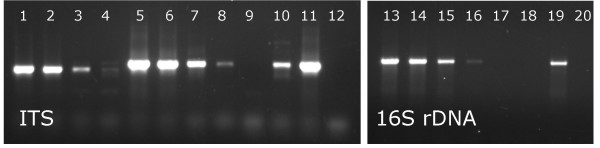
Contamination checking: PCR markers for fungi and bacteria in DNA isolated by the enzymatic method. Lines 1 to 12: Internal transcribed spacer (ITS) of ribosomal DNA amplified with eukaryotic specific universal primers ITS1 and ITS4 [17]. Lines 13 to 20: 16S ribosomal DNA amplified with prokaryotic specific universal primers 9f and 1429r [18]. Amplifications from respectively 10, 1, 0.1 and 0.01 pg of genomic DNA of Trichoderma longibrachiatum (lines 1 to 4), Ilex aquifolium (lines 5 to 8) and Artrospira sp. (lines 13 to 16). Amplifications of DNA isolated from a digestion mix alone (lines 9 and 17), a digestion mix "contaminated" with an Ilex aquifolium leaf disk removed after 10 min and further incubated overnight at 50°C (lines 10 and 18) and a mix digesting an Ilex aquifolium leaf disk overnight at 50°C (lines 11 and 19). Line 12 and 20: negative controls.